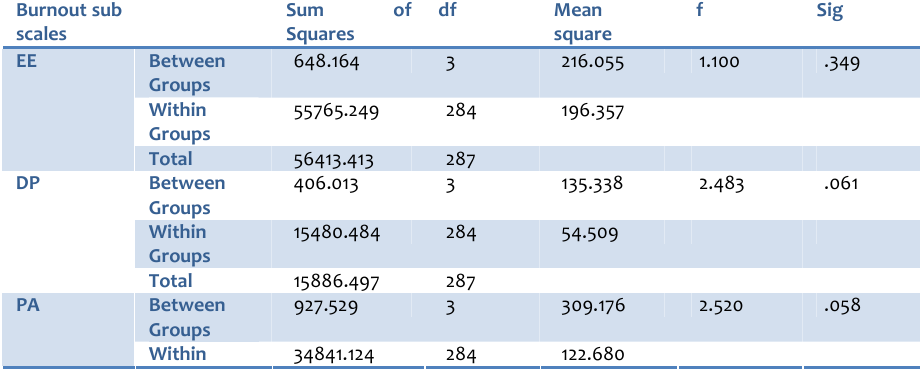
Table 13: Respondents’ Marital Status and Mean Scores of